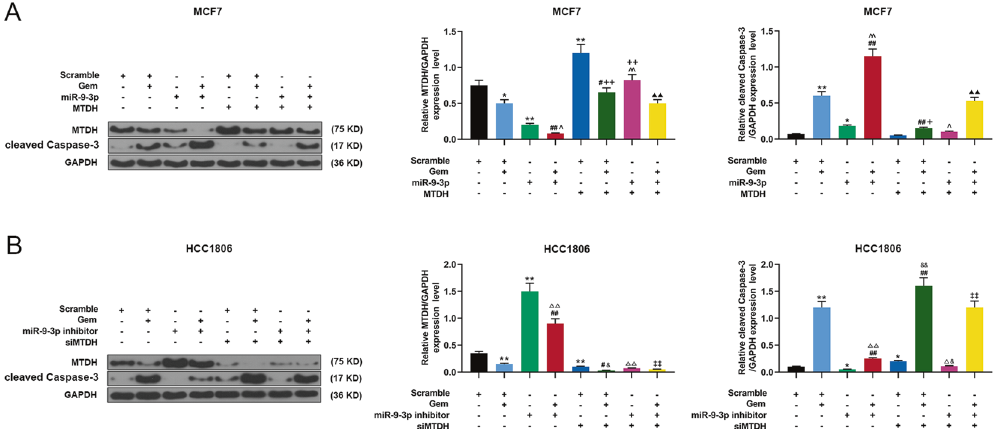
Fig. 8 The effects of miR-9-3p on apoptotic protein expressions of Gem-treated breast cancer cells by targeting MTDH. A Western blot and qRT-PCR were used to determine the effect of overexpressed MTDH, miR-9-3p mimics, and Gem on the expression of MTDH and cleaved caspase-3 in MCF7 cells. B Western blot and qRT-PCR were used to determine the effects of siMTDH, miR-9-3p inhibitor, and Gem on expressions of MTDH and cleaved caspase-3 of HCC1806 cells. ( n = 3, * P < 0.05, ** P < 0.01, *** P < 0.001, vs. Scramble; ## P < 0.01, vs. Scramble + Gem; ^^ P < 0.01, vs. miR-9 mimics) ( n = 3, + P < 0.05, ++ P < 0.01, vs. Scramble + MTDH; ▲ P < 0.05, ▲▲ P < 0.01, vs. miR-9 mimics + Gem; △△ P < 0.01, vs. miR-9 inhibitor; && P < 0.01, vs. Scramble + siMTDH; ‡‡ P < 0.01, vs. miR-9 inhibitor + Gem). MTDH Metadherin, QRT-PCR quantitative real-time polymerase chain